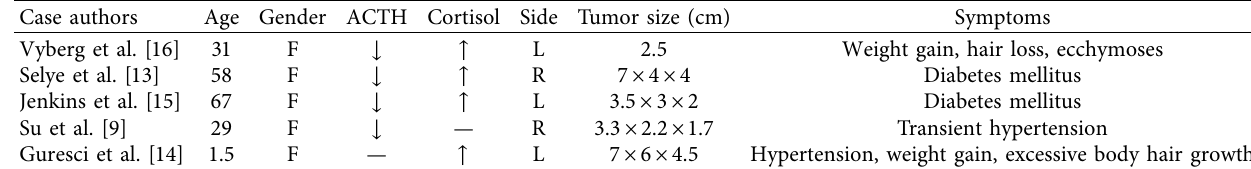
Table 1: Case reports of adrenal myelolipoma and functioning adrenal